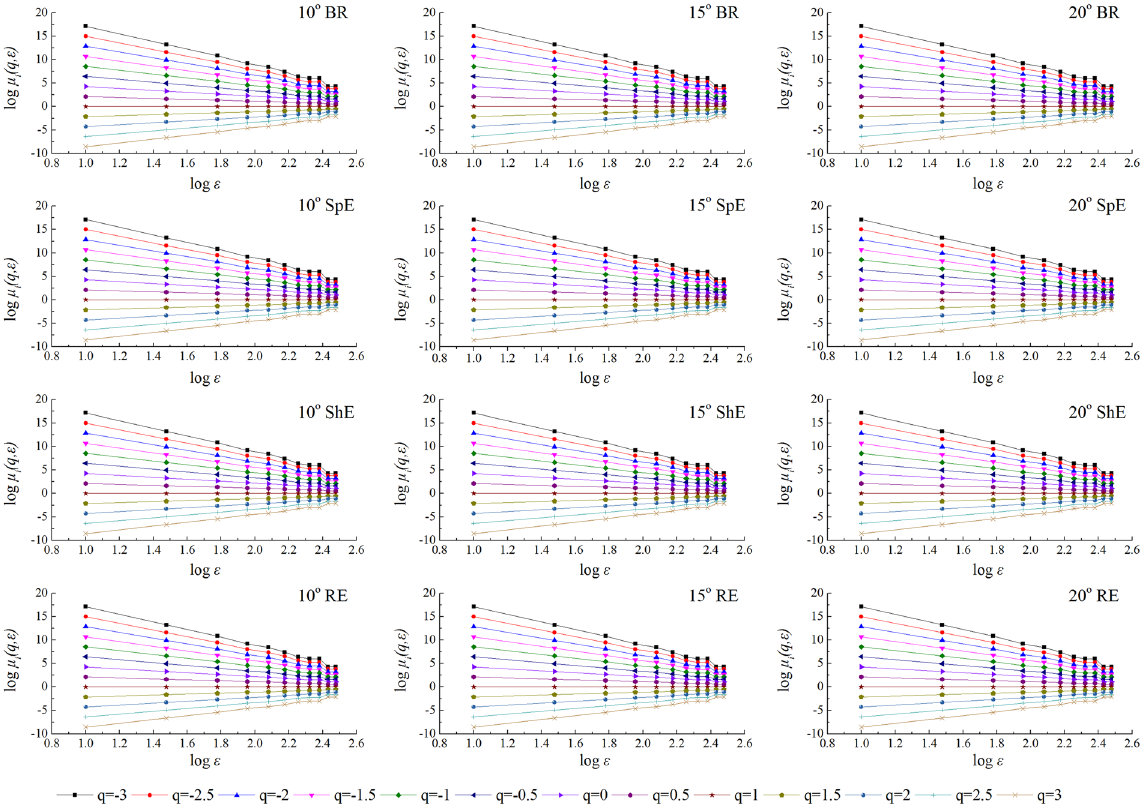
Figure 3. Relationship between log µ i ( q , ε ) and log ε of surface elevation at different erosive stages.